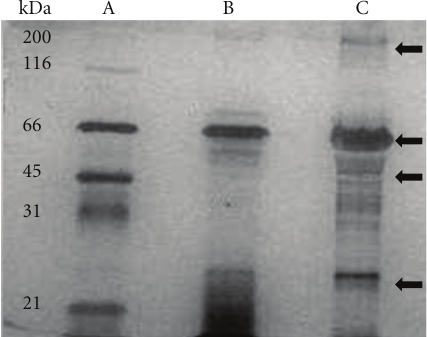
Figure 1: SDS-PAGE separation of the ESEA proteins visualized by silver staining. (A) (standard), (B) AU isolate, and (C) RG1 isolate. Arrows: common bands in both isolates.